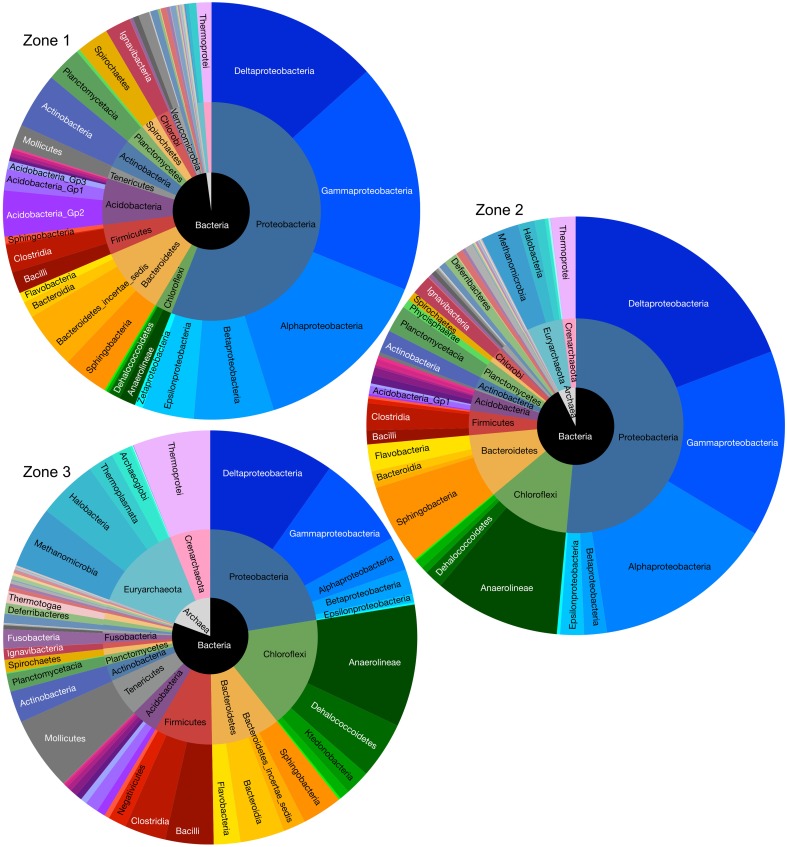
Microbial abundance and compositions of Zone 1, Zone 2, and Zone 3 in kingdom (inner circle), phylum (middle circle), and class (outer lever) taxonomic levels.